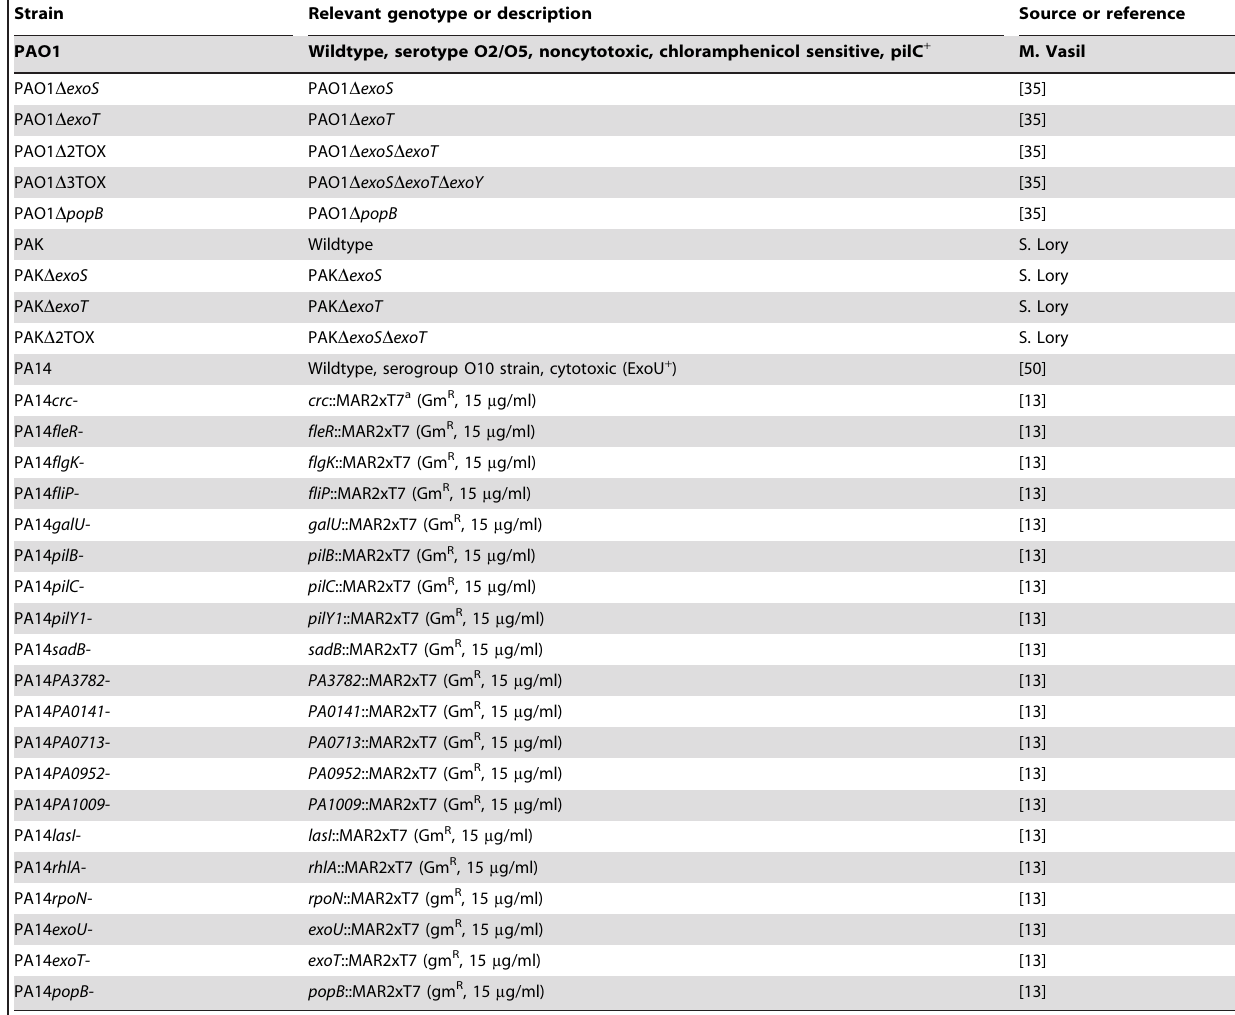
Table 4. Bacterial strains and genotype used in this study.